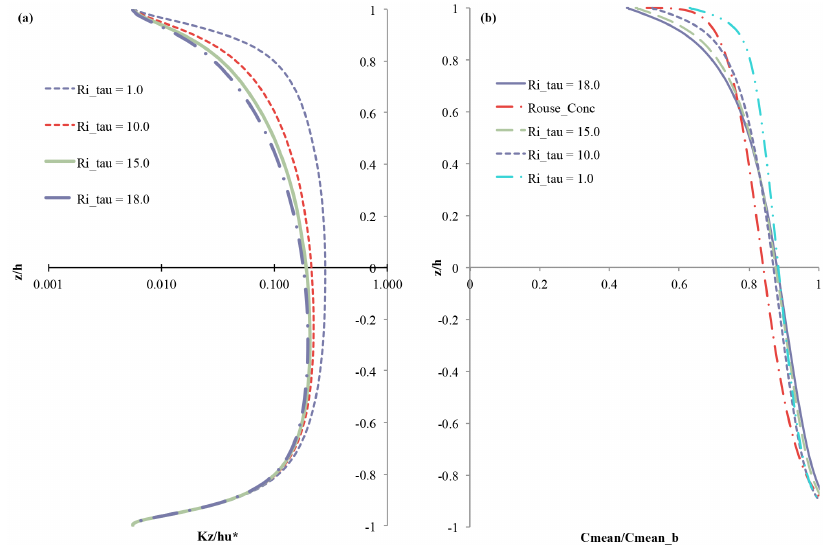
Figure 8. In (a) , the trend for vertical sediment diffusivity mirrors the trend found for turbulence intensity. An increase in the degree of self-stratification is found to decrease sediment diffusivity in the boundary layer. The extent to which sediment diffusivity decreases in the upper half of the boundary layer is slightly higher than the lower half of the boundary layer. This is not completely unexpected because mixing of suspended sediment is primarily dependent on turbulence in the flow. In (b) , normalized sediment concentration profiles from DNS simulations have been plotted along with the sediment profile obtained using the Rouse–Vanoni–Ippen relationship.